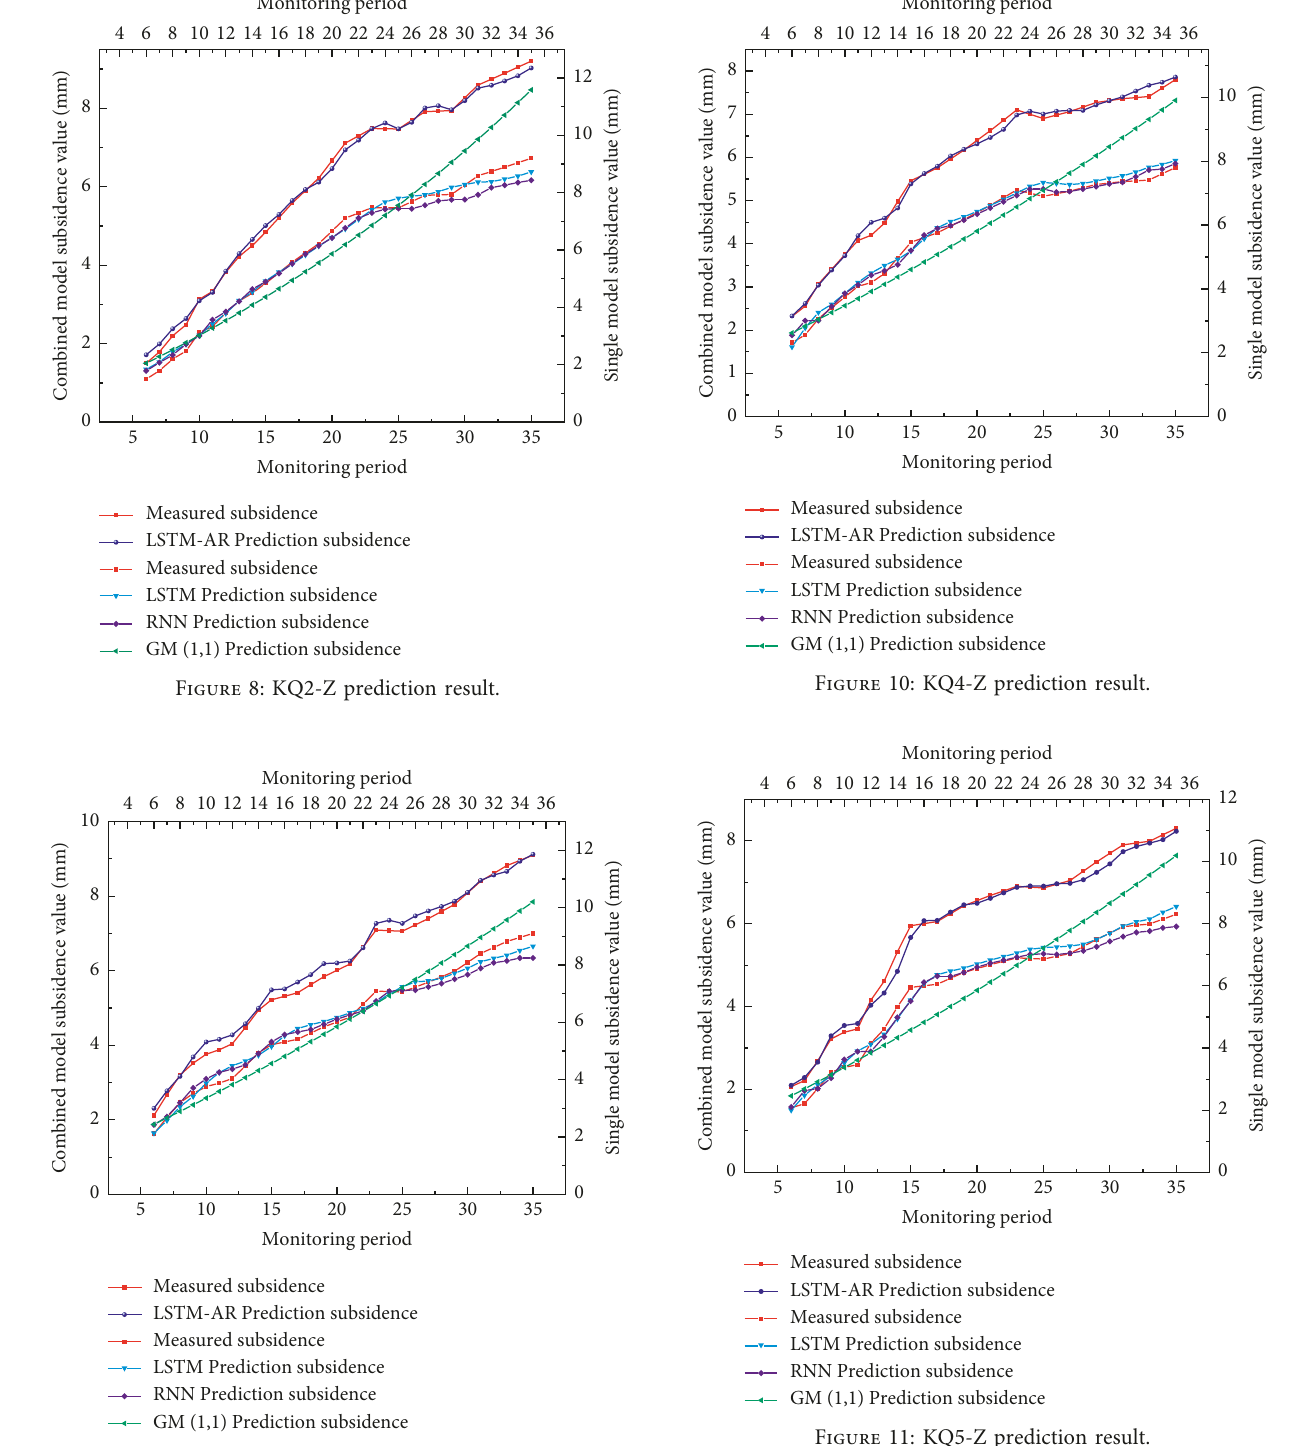
Figure 9: KQ3-Z prediction result.